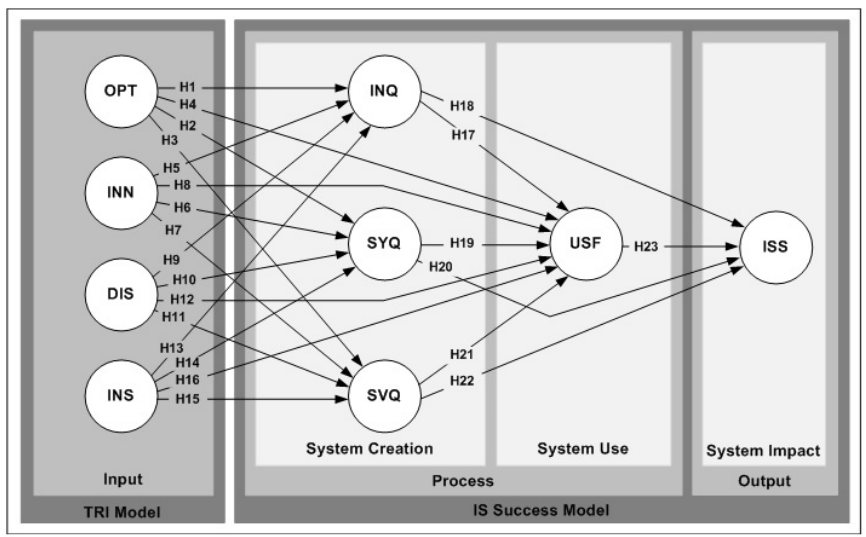
Figure 2. Hypothesis development of ISRS model following its development assumption [25,39,40,43].